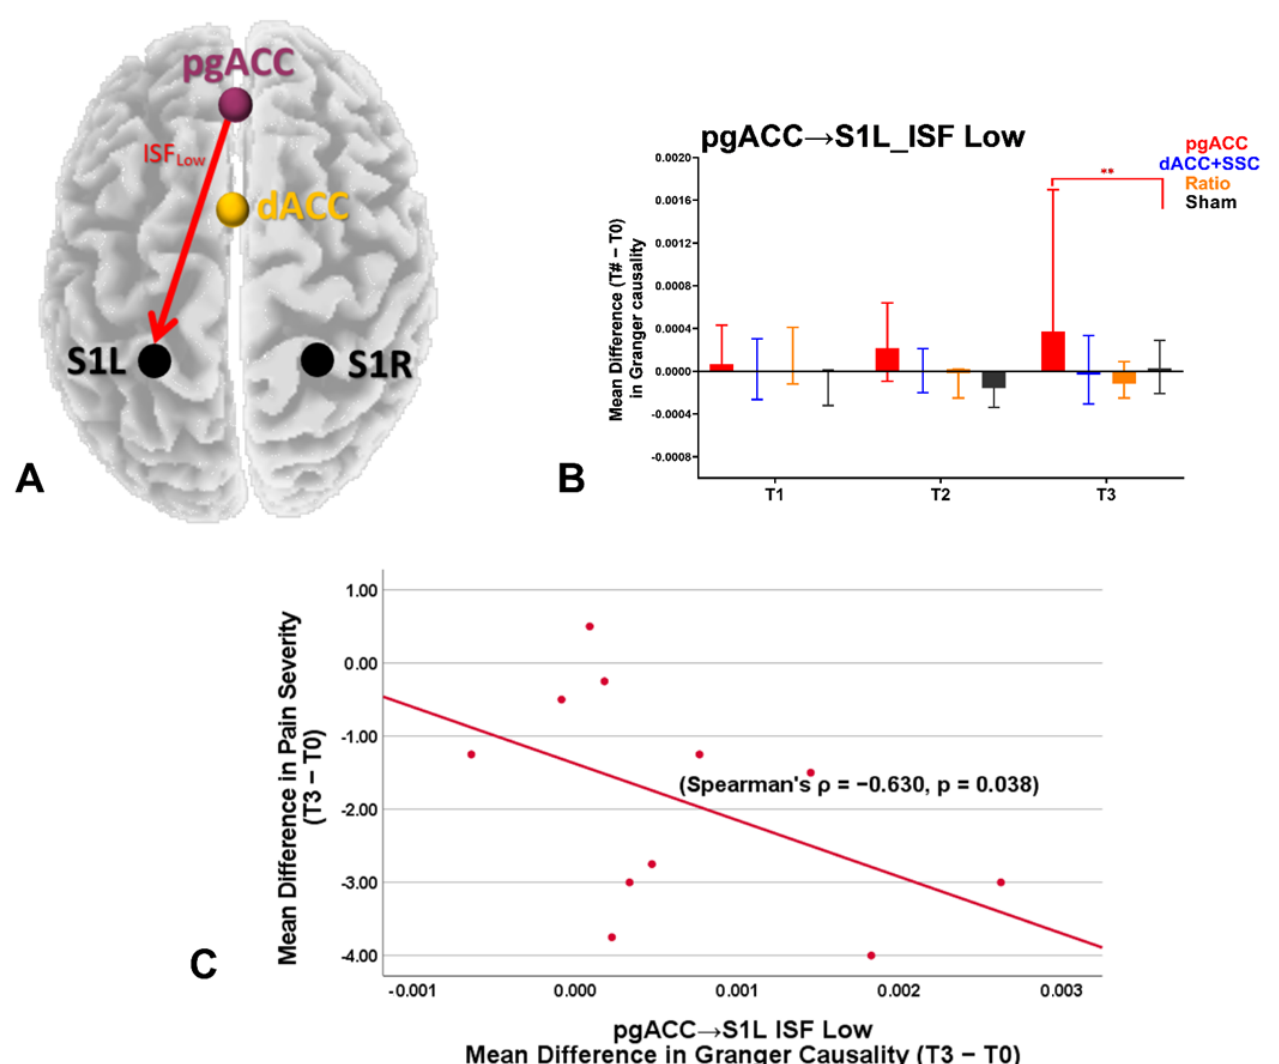
Figure 5. Summary of the results of the correlation analyses. In the ISF‑NF up‑training pgACC group, a significant increase in the effective connectivity was demonstrated in the direction of pgACC to the S1L ( A ), particularly in the ISF1 (low frequency) band at one‑month follow‑up ( B ), and the mean difference in the effective connectivity negatively correlated with the mean difference in the pain severity ( C ). **: Significant